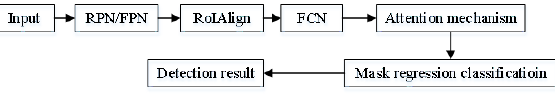
Fig. 2. Flow chart of improved mask